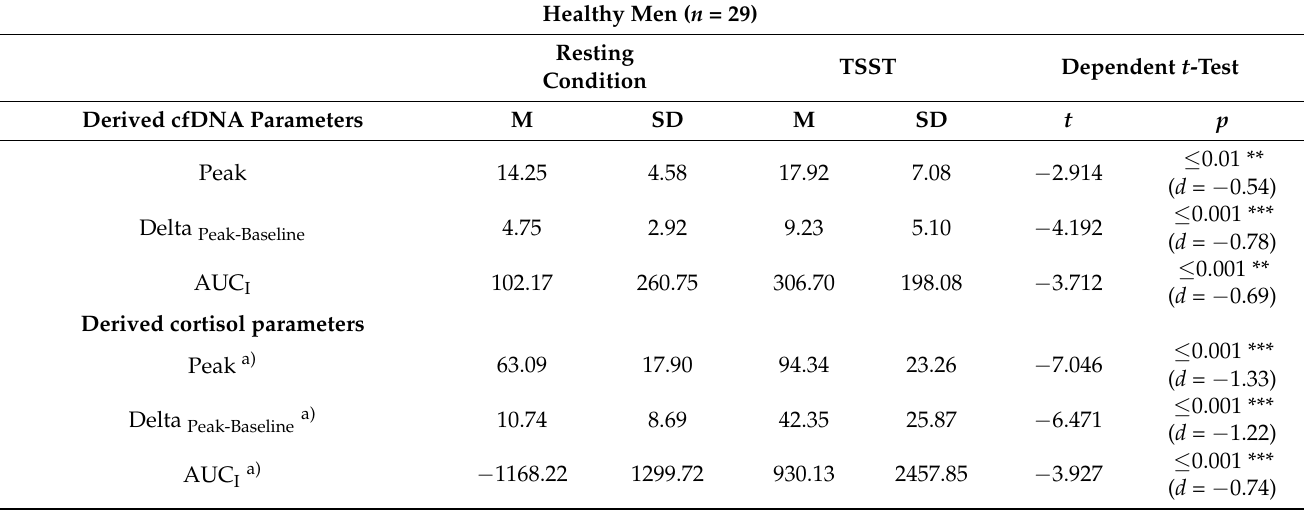
Figure 3. Cell-free DNA concentration ( A ) and cortisol concentration ( B ) during Trier Social Stress Test and resting condition in healthy men. Table 2. Derived cfDNA parameters, heart rate parameters and subjective appraisal with respect to